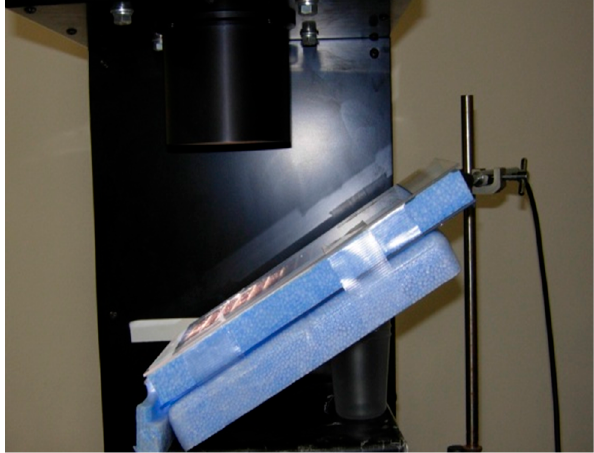
Technologies 2018 , 6 , x Figure 2. Exposure of OPV-solar chimney to solar spectrum light source. Figure 2. Exposure of OPV-solar chimney to solar spectrum light source.